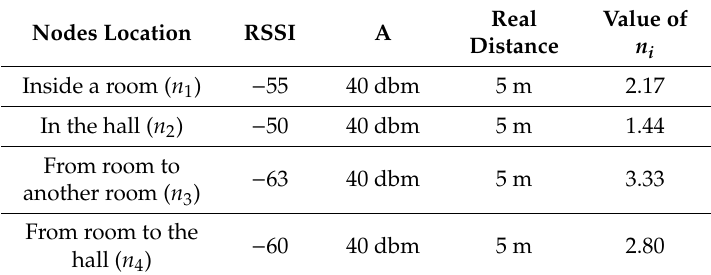
Table 7. The value of n in di ff erent